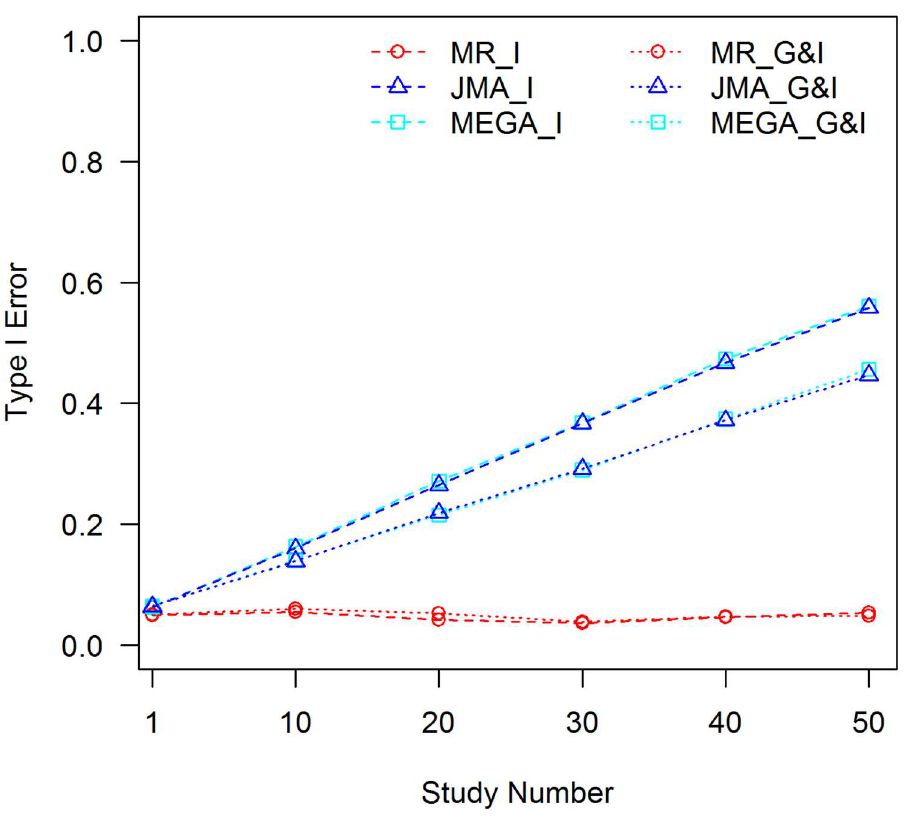
Fig 1. Tests of interaction without controlling for the C × E confounder, f 1 = 0.3, f 2 = 0.1. MR_I: MR test of interaction; MR_G&I: MR joint test of the geneticmain effect and interaction; JMA_I: JMA test of interaction; JMA_G&I: JMA joint test of the genetic main effect and interaction;MEGA_I: mega-analysis test of interaction; and MEGA_G&I: mega-analysis joint test of the genetic main effect and interaction.